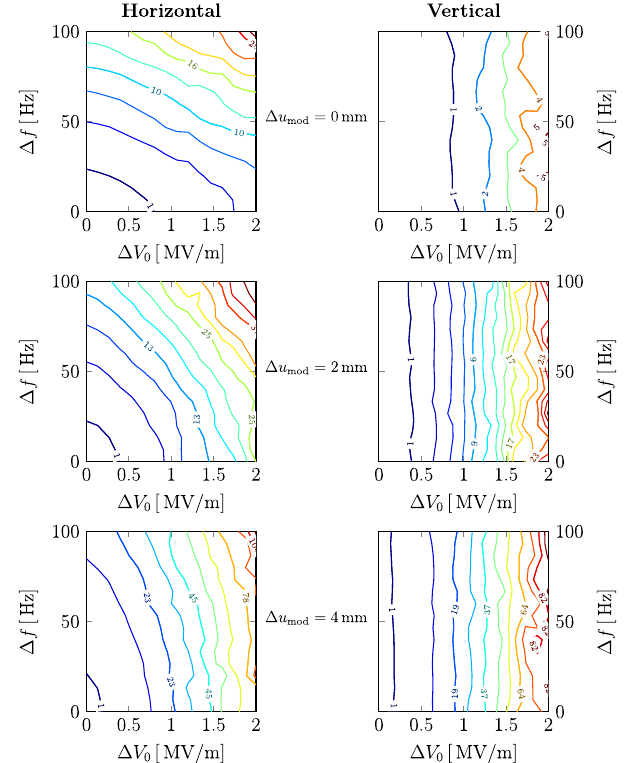
TABLE I. Parameter range for simulations at the injector module. Listed are the maximum values. Variations are consid- ered to be within one bunch-train.